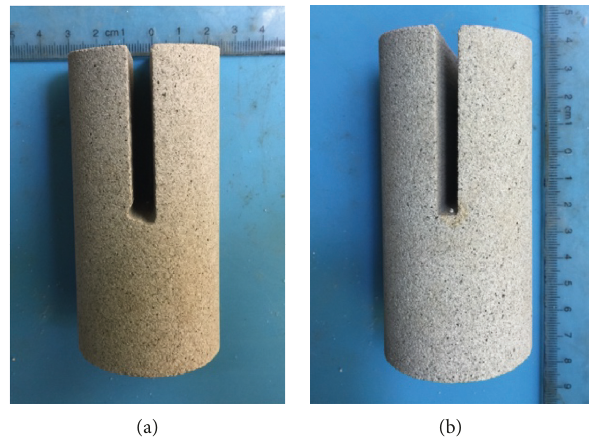
Figure 2: Prefabricated crack: 6 mm width and 50% length.